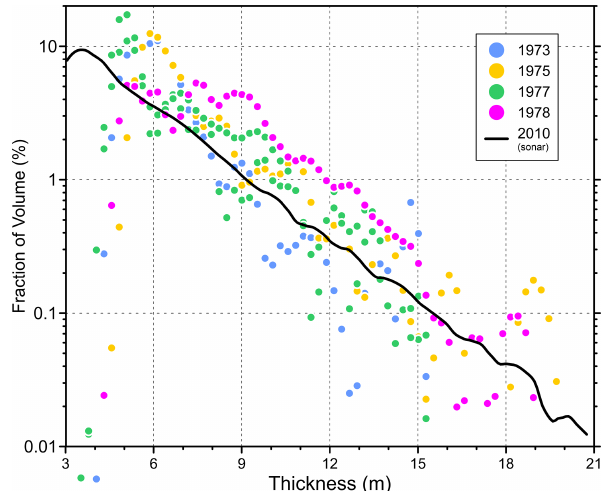
Figure 13. Distribution of pack-ice volume over ice thickness in the Penny Strait comparing recent data with surveys during the 1970s. The 2009 data have been adjusted to late winter 2010, as explained in the